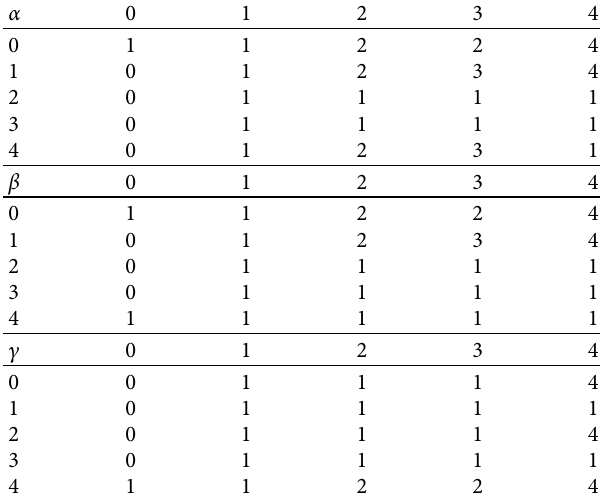
Table 13: Cayley tables for the binary operations “ α , β , and c